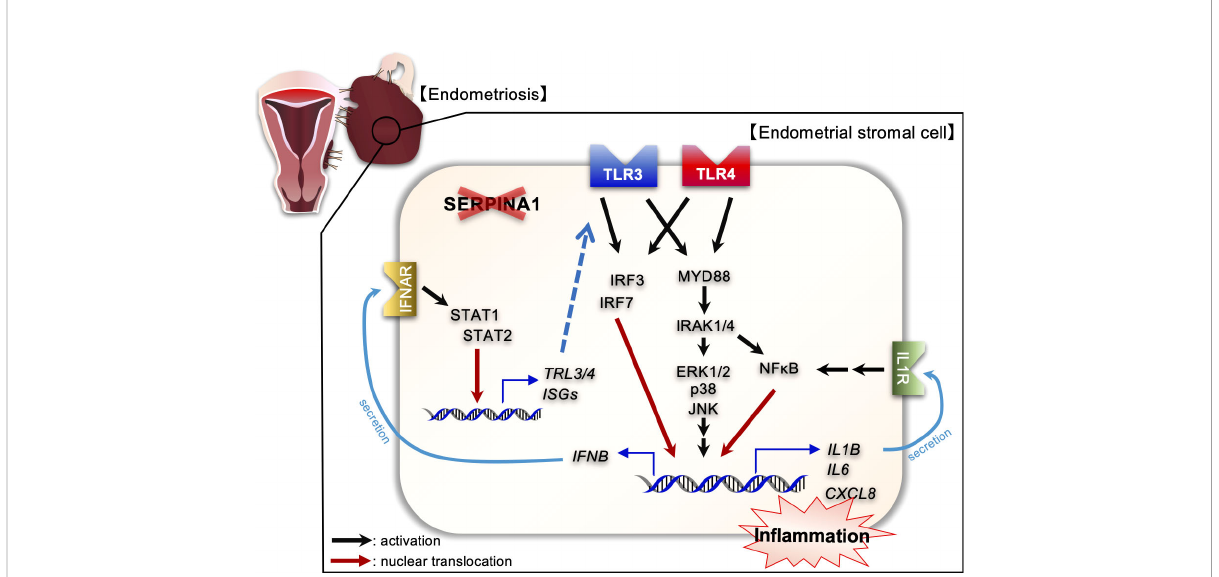
FIGURE 6 Diagram illustrating the effects of SERPINA1 knockdown on expression of in fl ammatory-related factors via TLR3/4 associated with endometriotic human endometrial stromal cells. SERPINA1 knockdown induces and activates TLR3 and TLR4 signaling, leading to production of in fl ammatory cytokines, of which IL-1 b or IFN- b promote expression of in fl ammatory-related genes in an autocrine